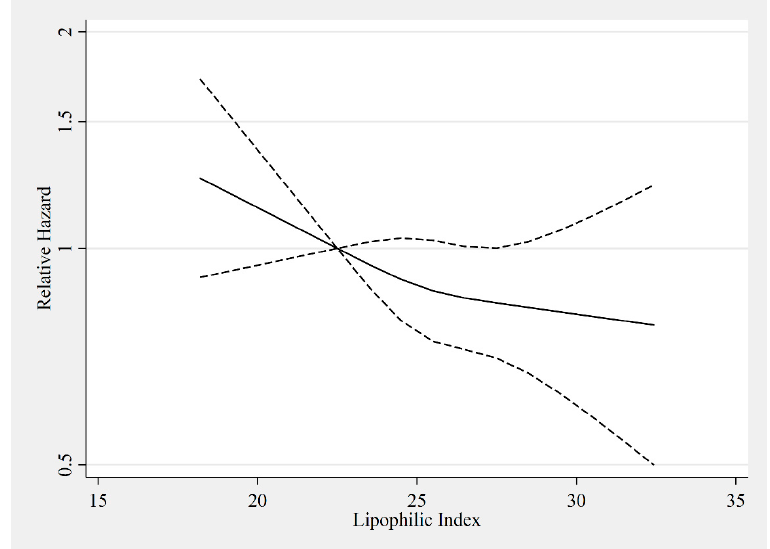
Figure 2. The association between lipophilic index and ischemic stroke illustrated by restricted cubic splines with three knots (solid line) and the 95% confidence interval (dashed line) showing the hazard ratio as a function of the lipophilic index (°C). Model 1b: adjustments for sex, age at baseline, alcohol intake, waistline adjusted for body mass index, education, smoking habits, and physical activity level. The reference value was 22.5 °C.